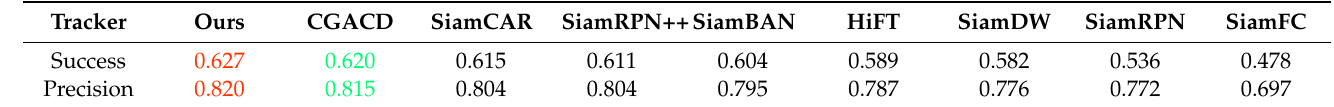
Table 1. UAV123 benchmark comparison table, the table shows the success rate and precision results of 9 trackers including ours. The proposed SiamHAS performs favorably against state-of-the-art trackers. The best method is shown in red, and the second is shown in